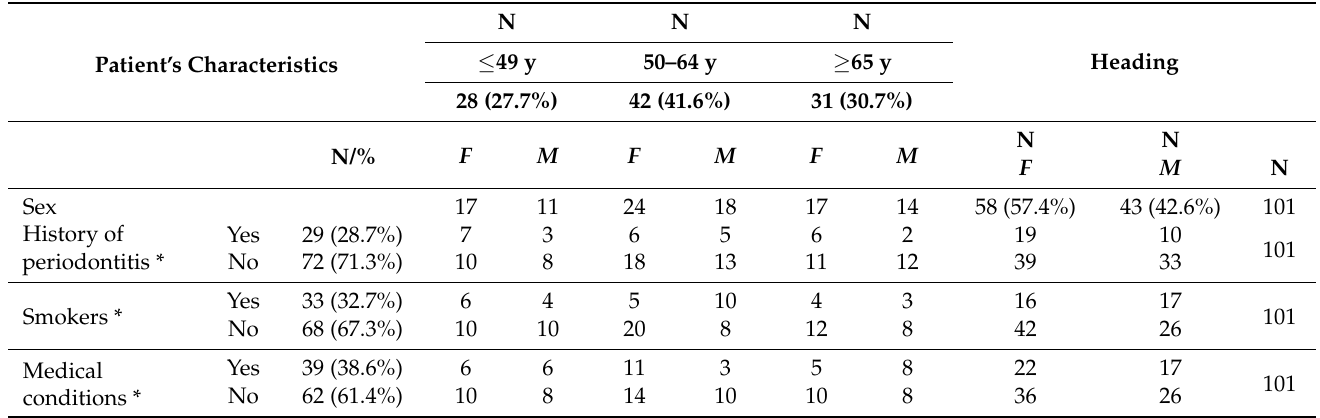
Table 1. Description of patient characteristics.